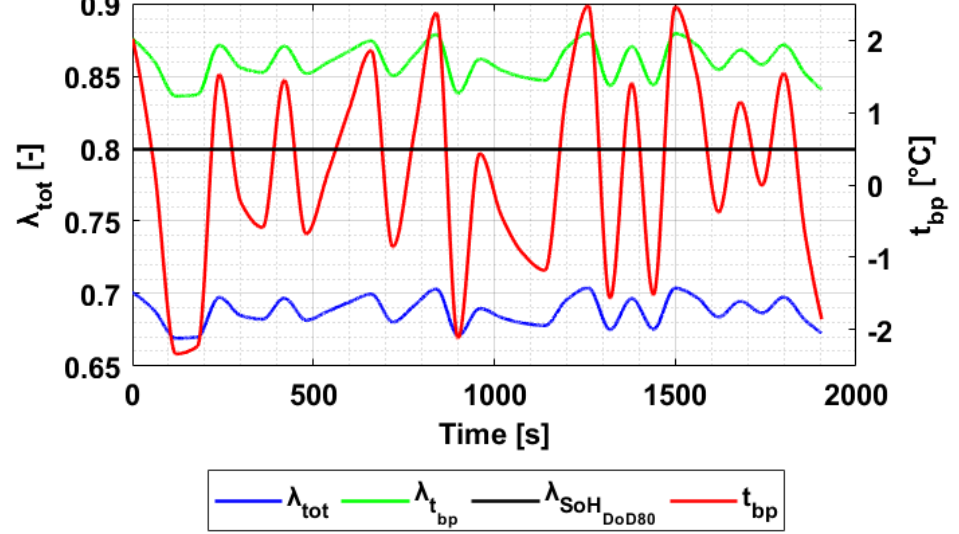
Figure 25. Combined effect of the battery pack temperature and the battery ageing level on λ tot for DM25 in the case of a battery with 600 life-cycles completed and DoD80.